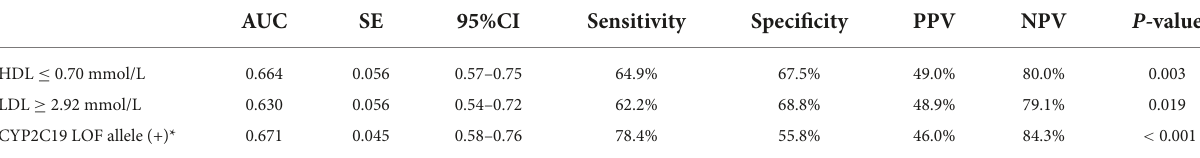
TABLE 5 The cut-off values of prediction CR with CYP2C19 LOF, HDL, and